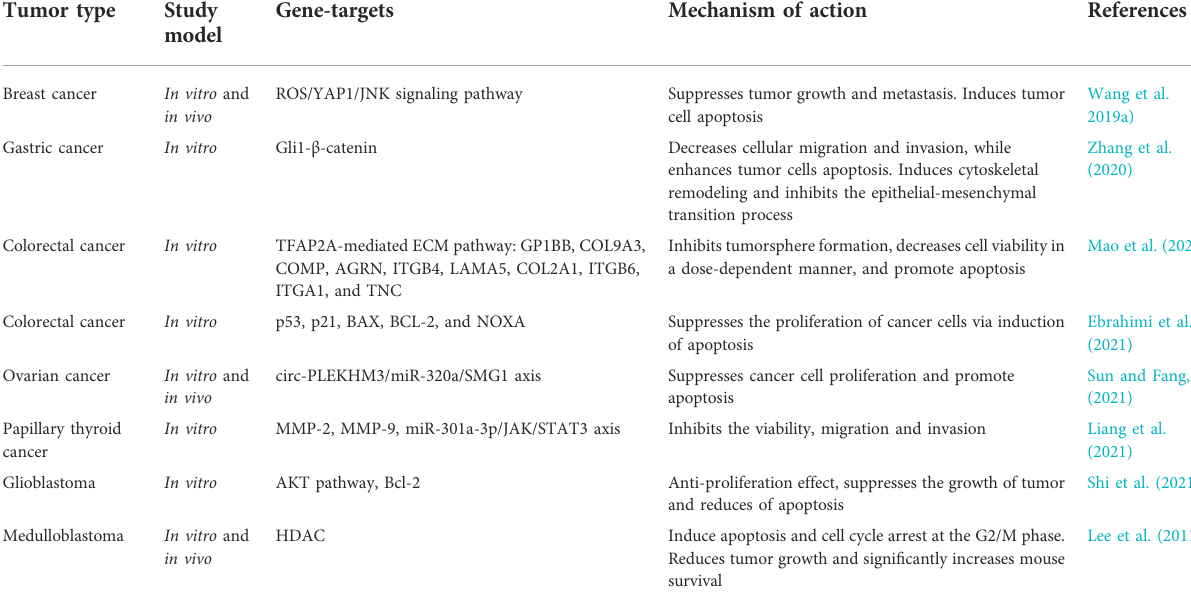
TABLE 2 Results of some preclinical experiments on the study of the therapeutic effect of curcumin in